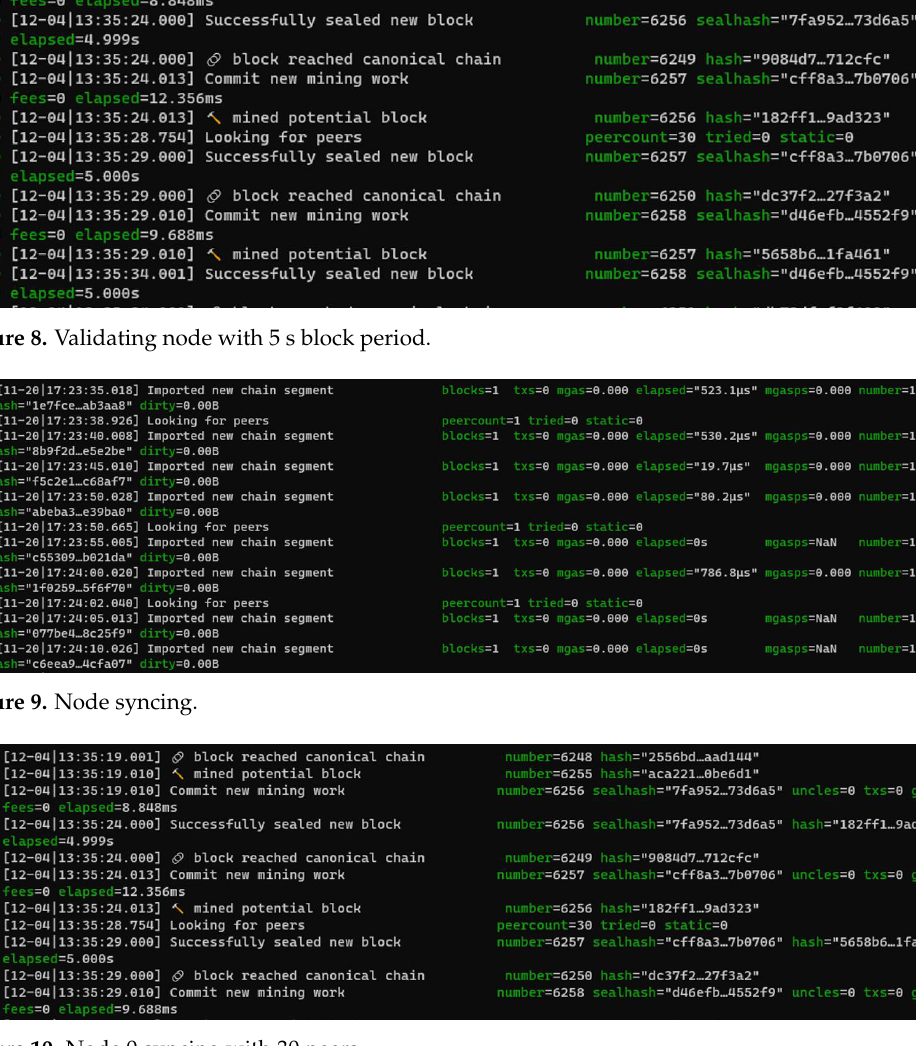
Figure 10. Node 0 syncing with 30